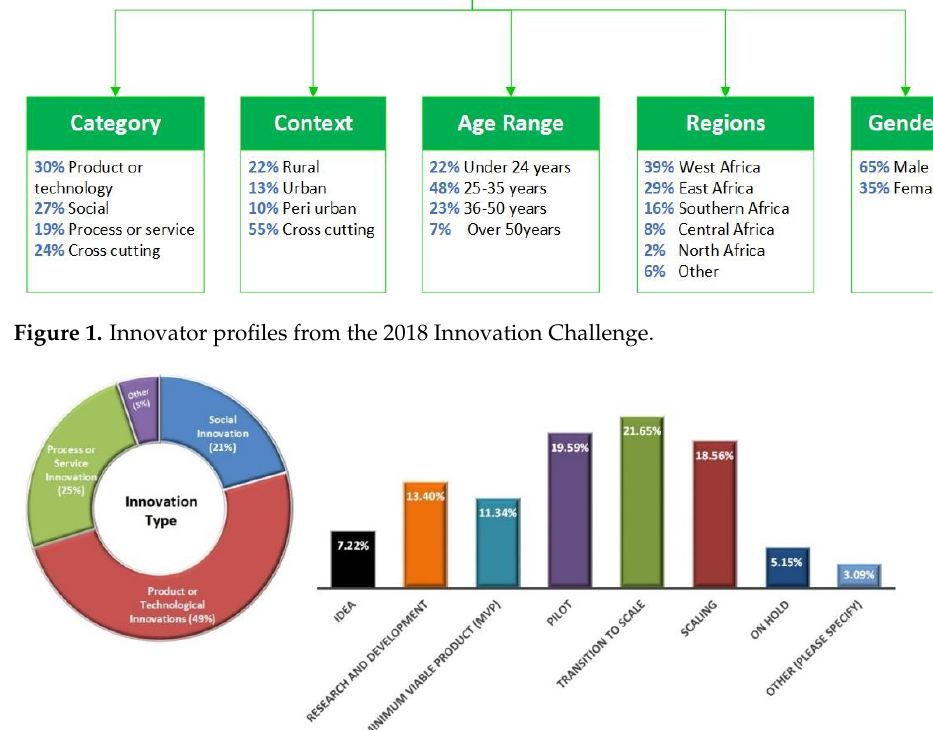
Figure 1. Innovator profiles from the 2018 Innovation Challenge.